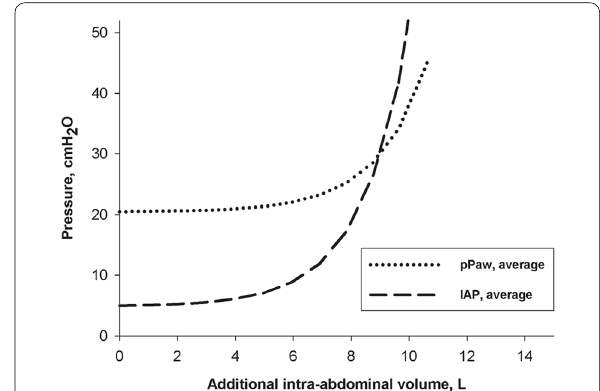
Fig. 3 Exponential pressure–volume curves of intra-abdominal pressure (IAP) (dashed curve) and peak airway pressure (pPAW) (dotted curve) in centimetre of water in function of increasing additional intra-abdominal volume in litres derived from 7 pigs. Figure reproduced with permission from Regli et al.